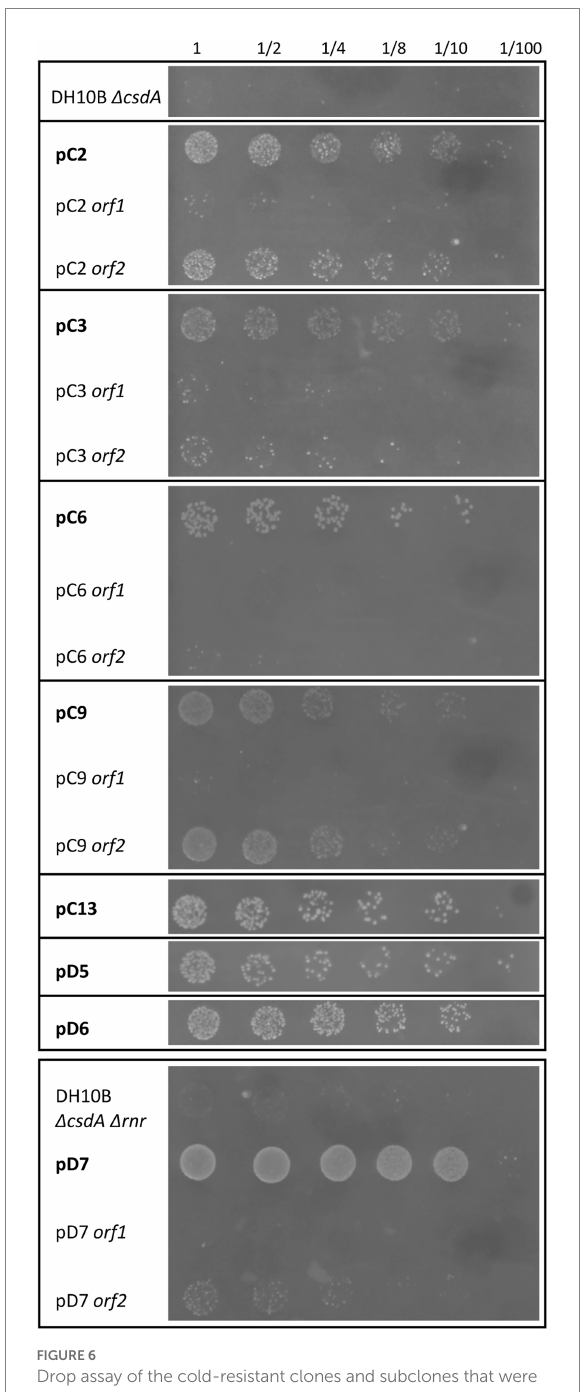
FIGURE 6 Drop assay of the cold-resistant clones and subclones that were also resistant to UV-B radiation. Both cold-sensitive strains (DH10B Δ csdA and DH10B Δ csdA Δ rnr ) carrying empty pBluescript vector were used as negative controls. The cell density of overnight cultures was adjusted to OD 600 nm values of 1.0, serial dilutions were performed and 10 μl drops of each dilution were inoculated on LB-Ap 50 plates and irradiated with a dose of UV-B of 4 mJ/cm 2 . UV-B resistance was evaluated after growing cells overnight at 37 ° C. Each experiment was repeated at least three times using independent